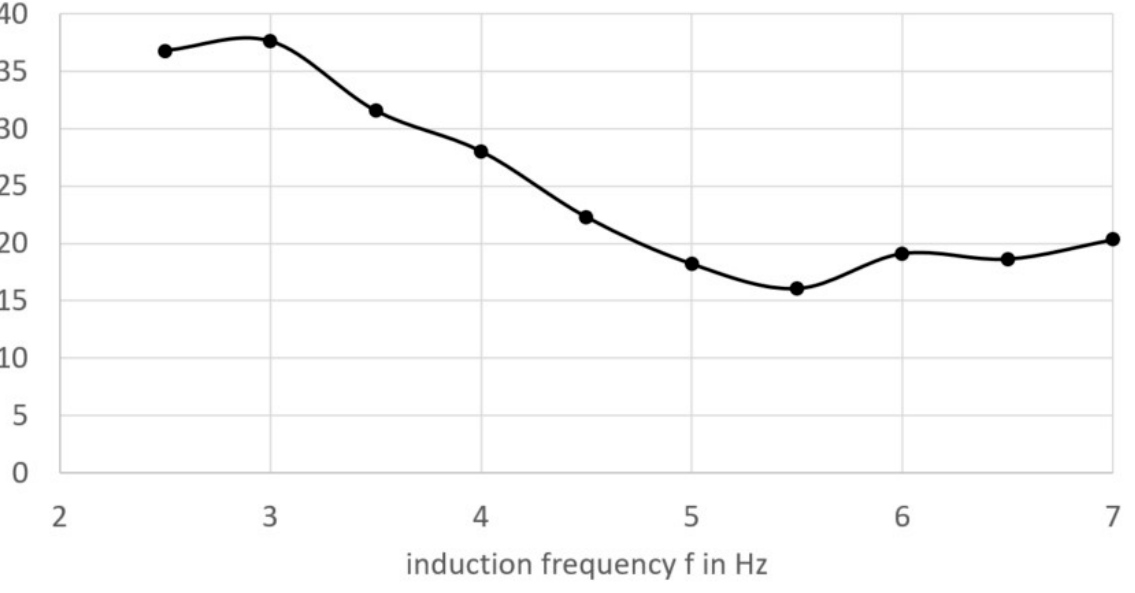
Figure 6. Thermal oscillation amplitude at 2f as a function of the induction frequency f.